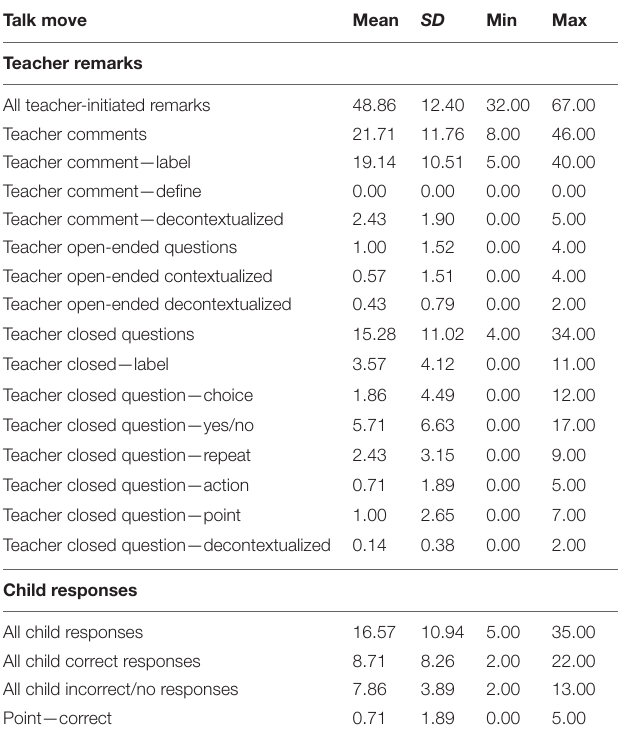
TABLE 4 | Descriptive statistics of talk